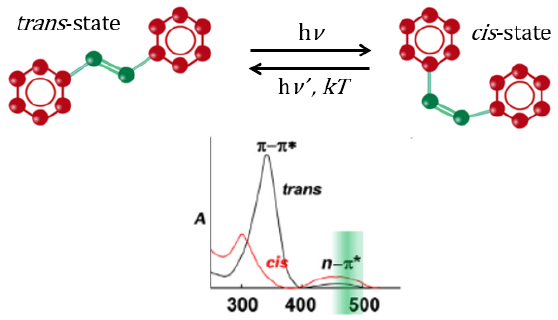
Figure 2. Reversible trans-cis-trans isomerization of azo-dyes derivatives and representative absorption spectra of trans and cis isomers [38].